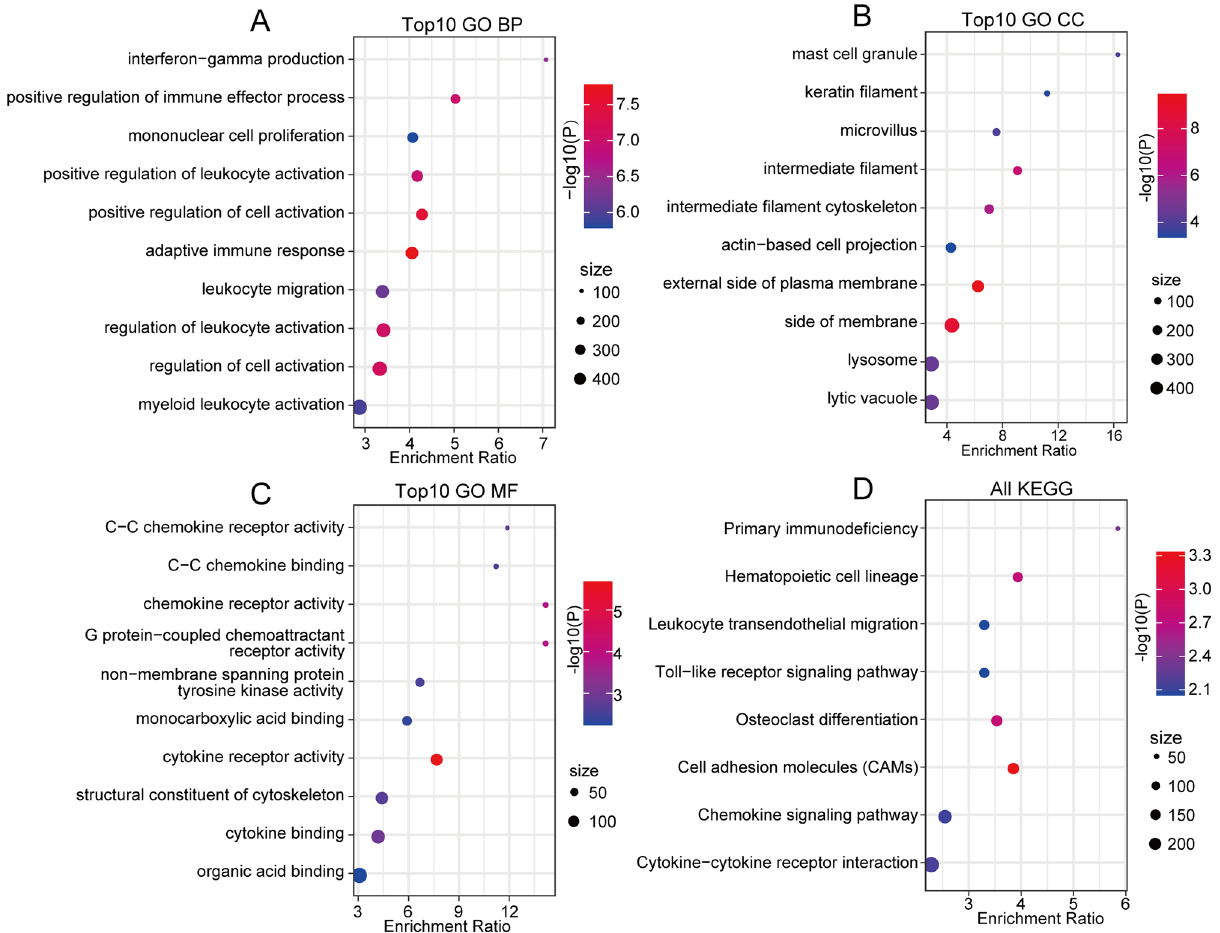
(BP: biological process; MF: molecular function; CC: Cell